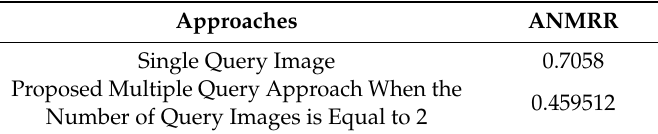
Figure 2. Proposed approach performance with respect to the number of query images. Table 4. The performance of the proposed multiple query approach when the number of query images is equal to 2 compared to the performance of a simple query image using the concatenated features based on ANMRR.